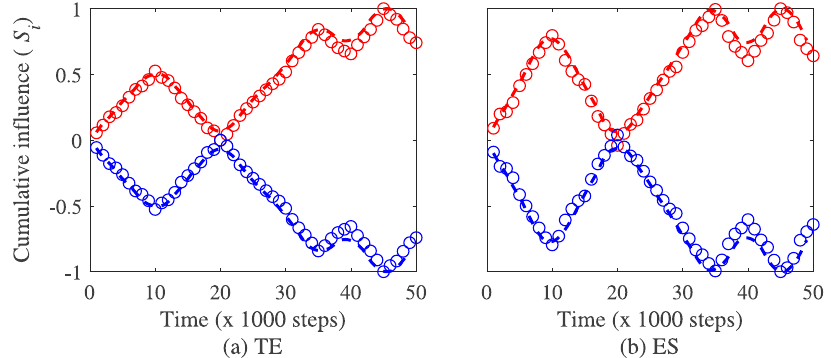
Figure 6. Time trace of the cumulative influence index of particle 1 on particle 2 (red) and particle 2 on particle 1 (blue) in an experiment where five switching events are simulated including 2 occurring after 10,000 time- steps, one after 15,000 time-steps, and 2 occurring after 5,000 time-steps. Note that the values of the cumulative influence ( S i ) are normalized between − 1 and 1. Model parameters retained in the simulations are N = 2, K = 2, v = 0.05, and η = 0.2.